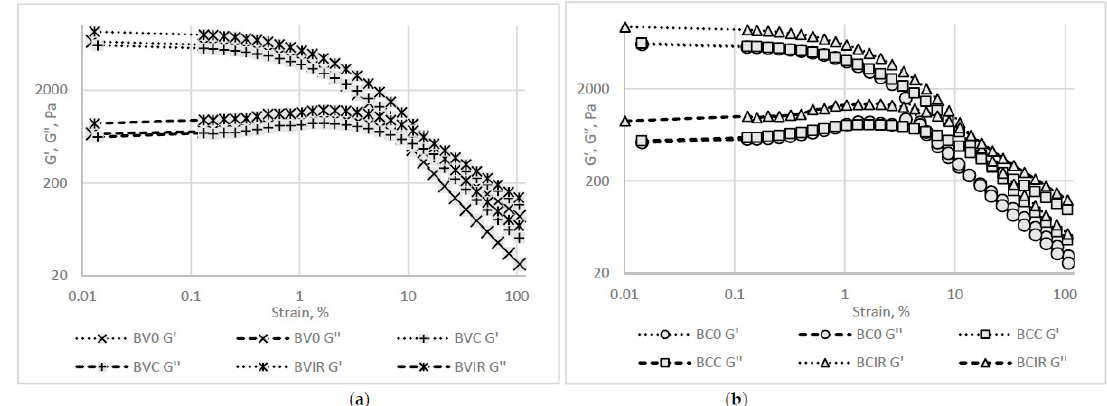
Figure 4. Rheological behavior as revealed by the strain sweep test: ( a ) Beta vulgaris L. var. vulgaris , ( b ) Beta vulgaris L. var. cylindra .